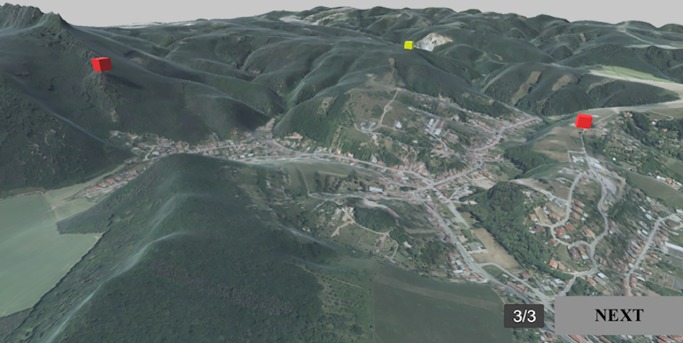
Example of Task 1 –Cubes in the terrain.Yellow indicates that this object was selected by the participant. Adapted from [61] under a CC BY license, with permission from [ČÚZK], original copyright [2018/2019].